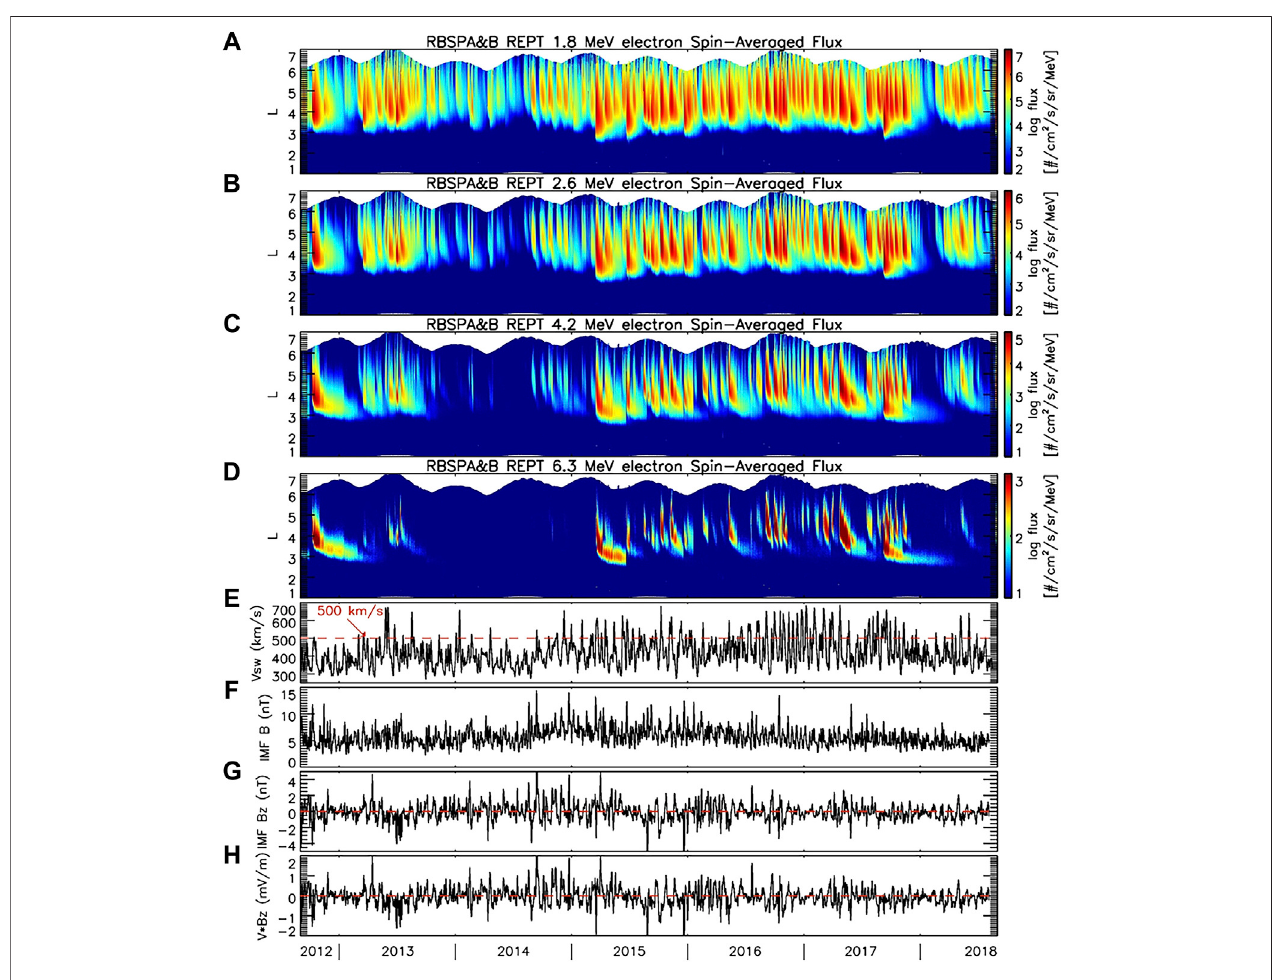
FIGURE1| Six years ofMeVelectron fl uxes inthe Earth ’ sradiationbelts,at (A) 1.8 MeV, (B) 2.6 MeV, (C) 4.2 MeV, and (D) 6.3 MeV,measuredbyboth VanAllen Probes between 1 September 2012 and 1 September 2018, together with information on the solar wind properties, namely, the three-day running averages for (E) the solarwind speed, (F) themagnitudeoftheinterplanetarymagnetic fi eld(IMF), (G) thenorth-southcomponent oftheIMF, Bz, and (H) theproductofsolarwindspeed, V, and Bz (from Baker et al., 2019).